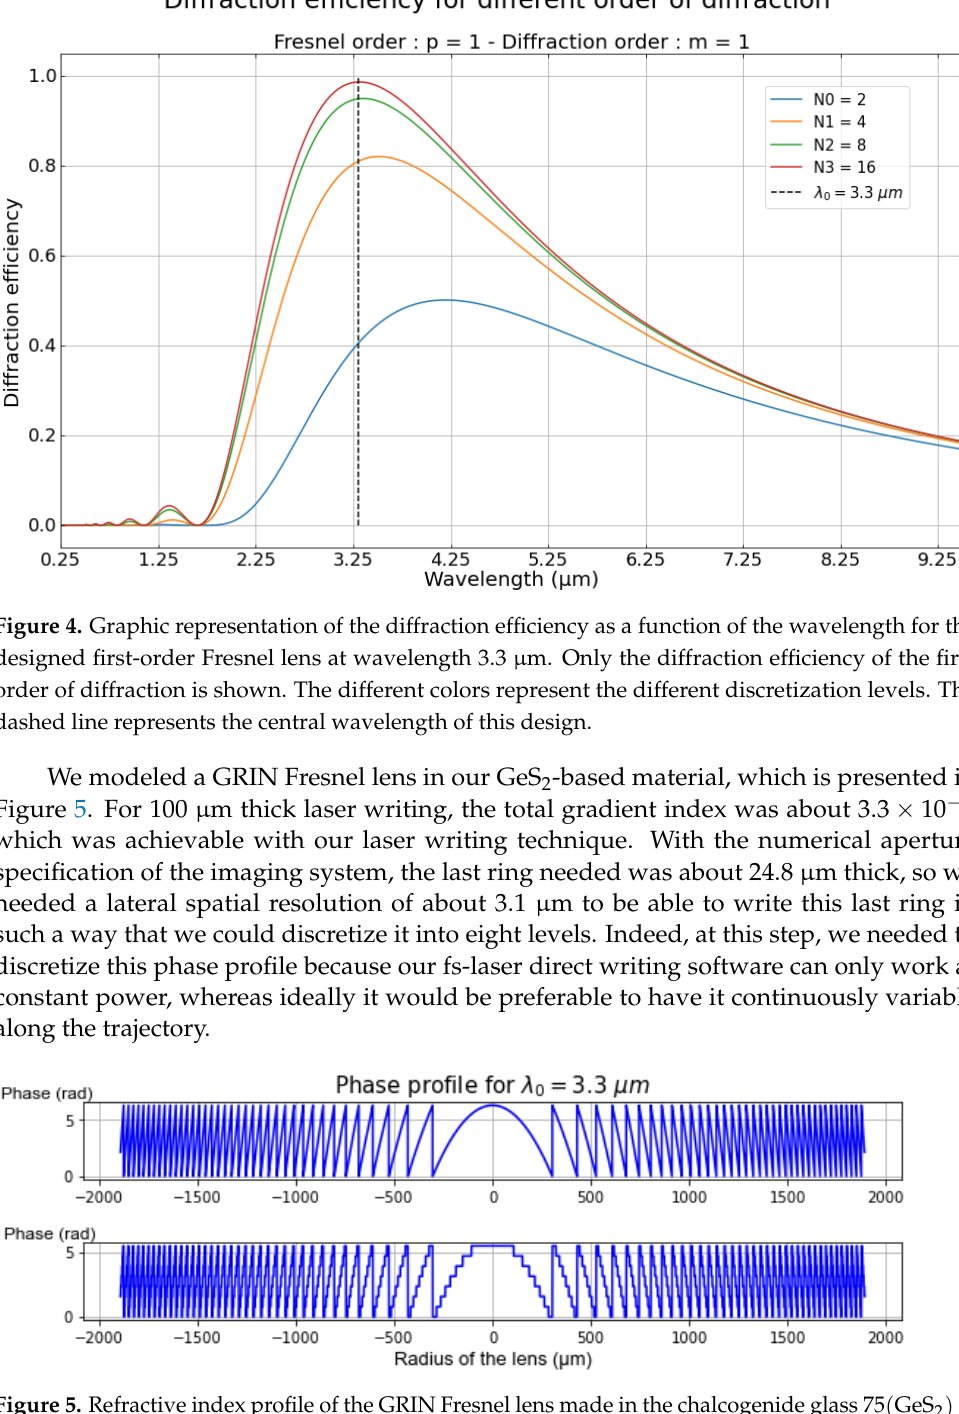
Figure 5. Refractive index profile of the GRIN Fresnel lens made in the chalcogenide glass 75(GeS 2 ) − 15(In 2 S 3 ) − 10(CsCl) : blazed on the top and discretized on the bottom.